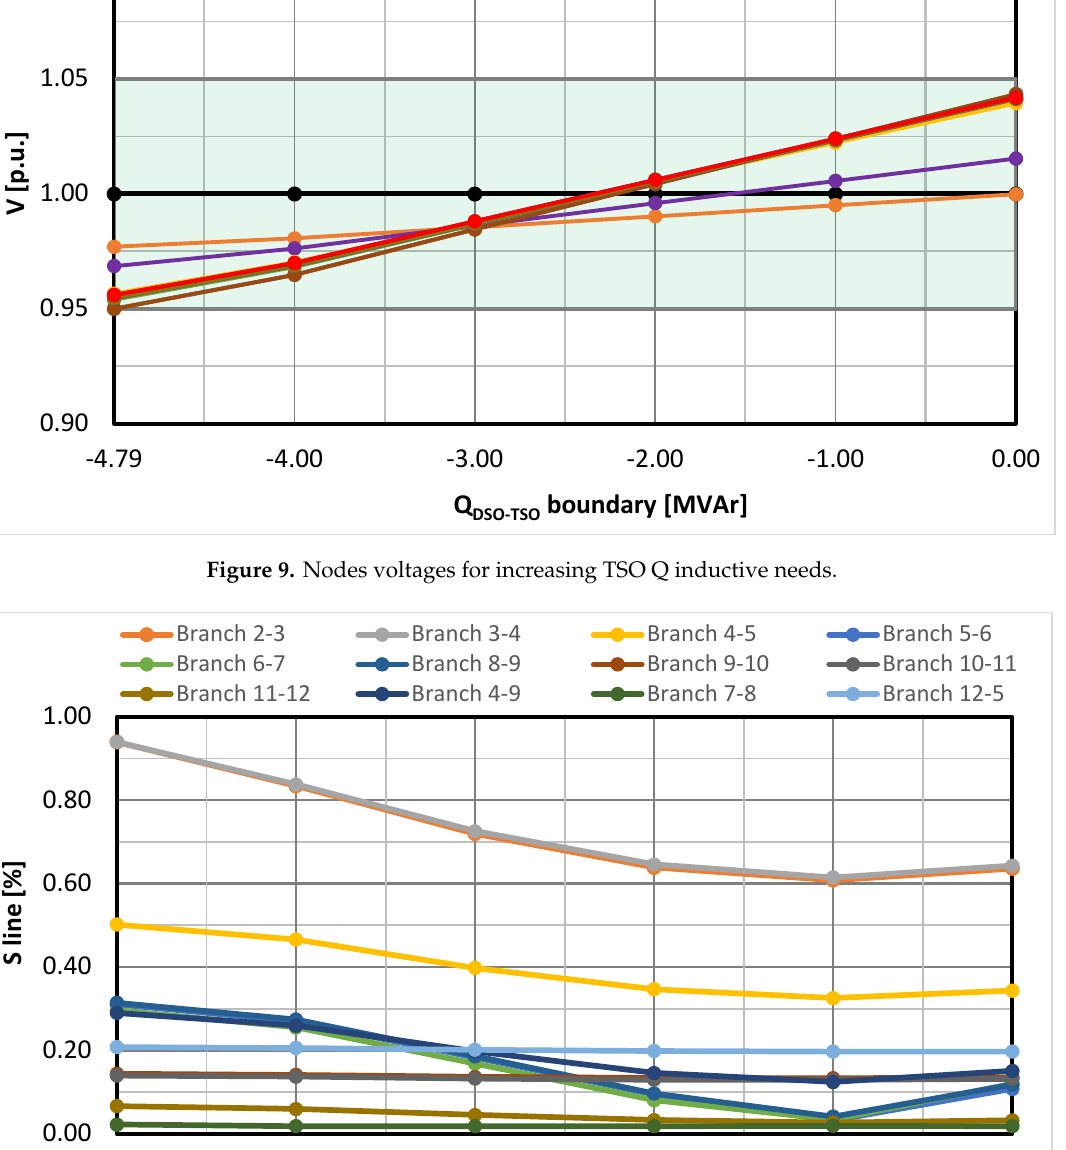
Figure 10. Lines usage for increasing TSO Q inductive needs.